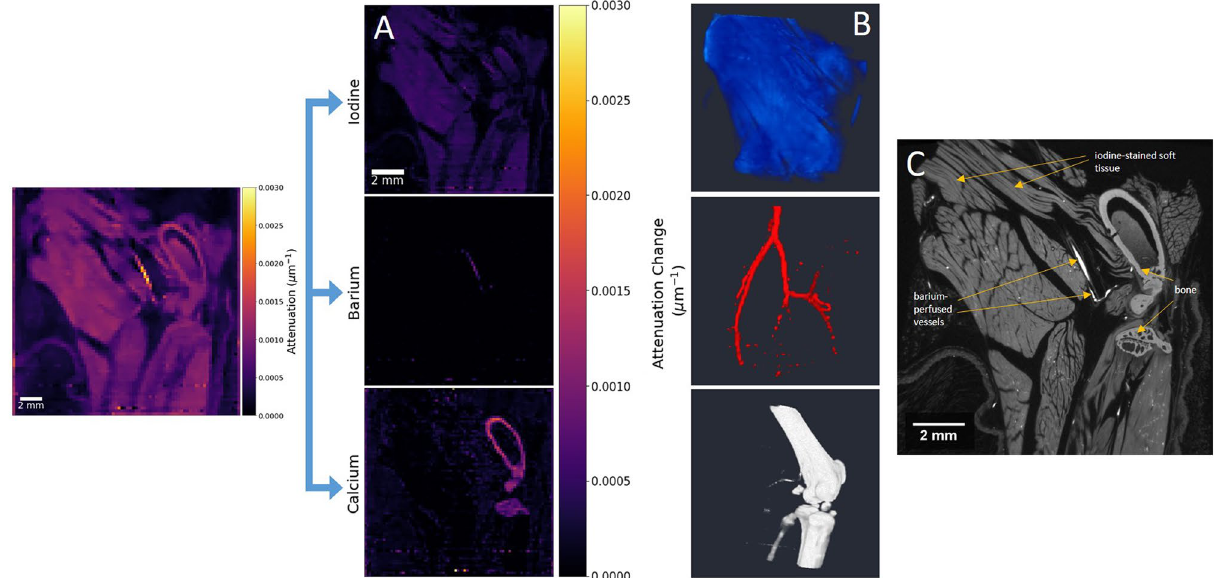
Figure 3. Elemental segmentation of hindlimb by K-edge subtraction. ( A ) Elemental difference maps shown for the hyperspectral image slice shown in the sagittal plane (left). Colour bar for elemental difference maps is measured in terms of attenuation change, Δµ, as determined by KES of narrow energy windows (5 channels, ≈ 1.1 keV width total) either side of each absorption edge. ( B ) 3D volume mapping for elemental maps of iodine-, barium- and calcium-containing regions (top, middle, bottom respectively). ( C ) Virtual cross-section from a high spatial resolution XCT scan of the mouse hindlimb, showing the equivalent image slice following volume registration. Labels indicate the three material phases with expected stain uptake